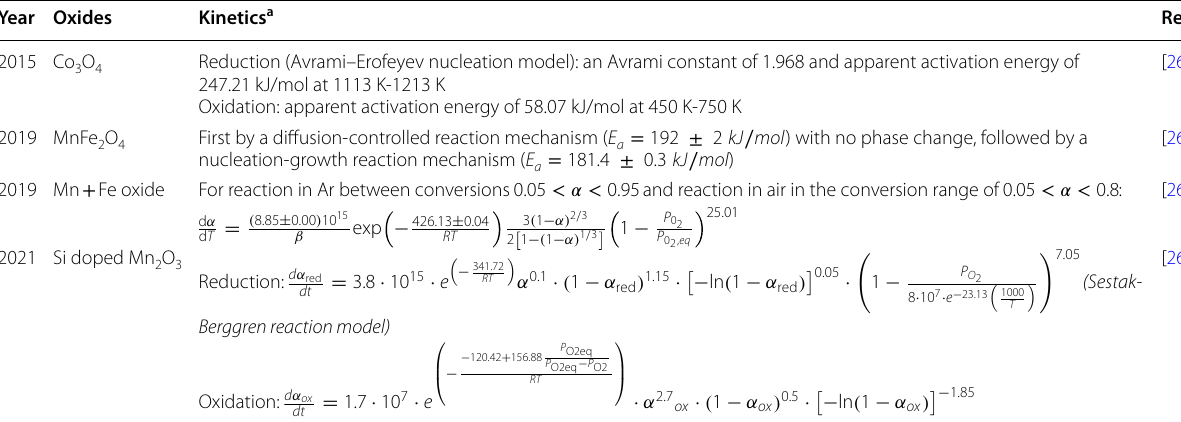
Table 14 Recent studies on reaction kinetics of metal oxide redox reactions